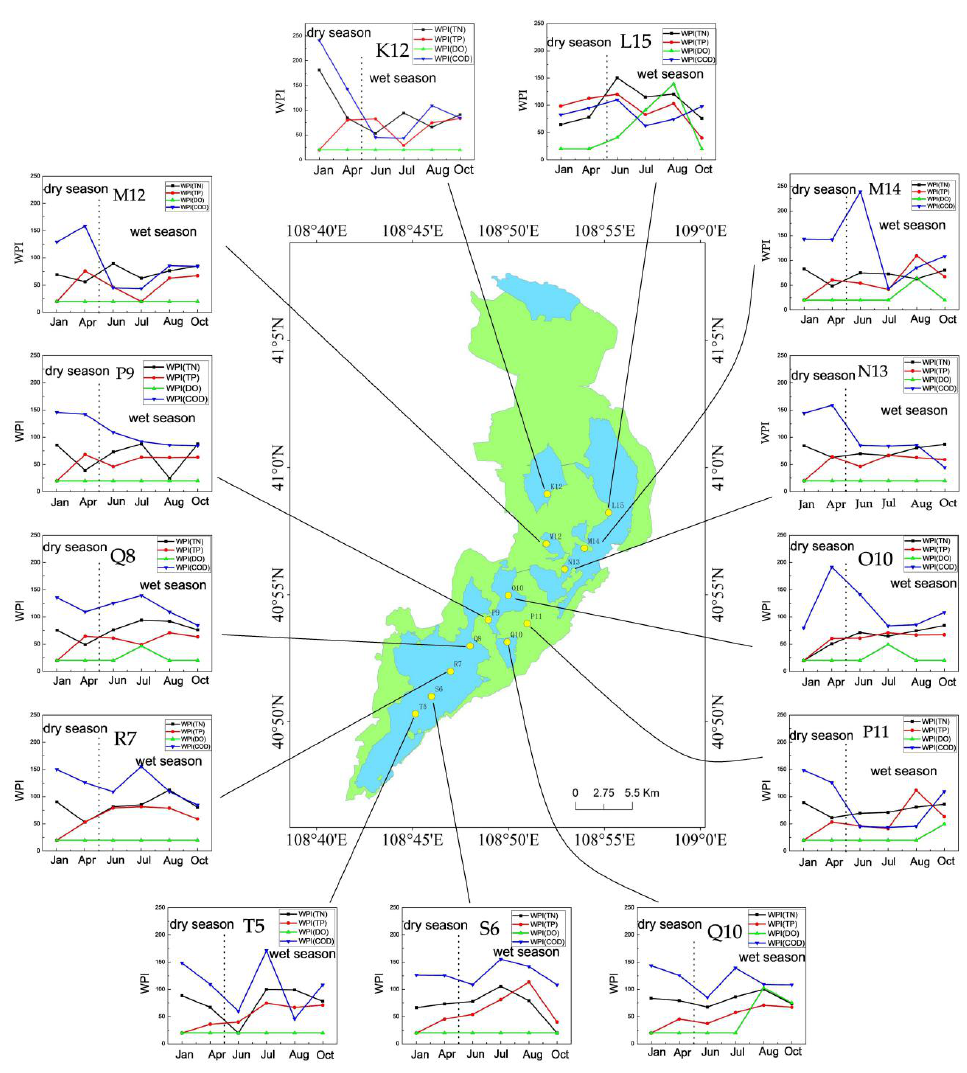
Figure 7. Temporal variation in the WPI at each sampling sites in 2017. Table 3. Temporal variation trends calculated by the Daniel trend test method at the 13 sampling